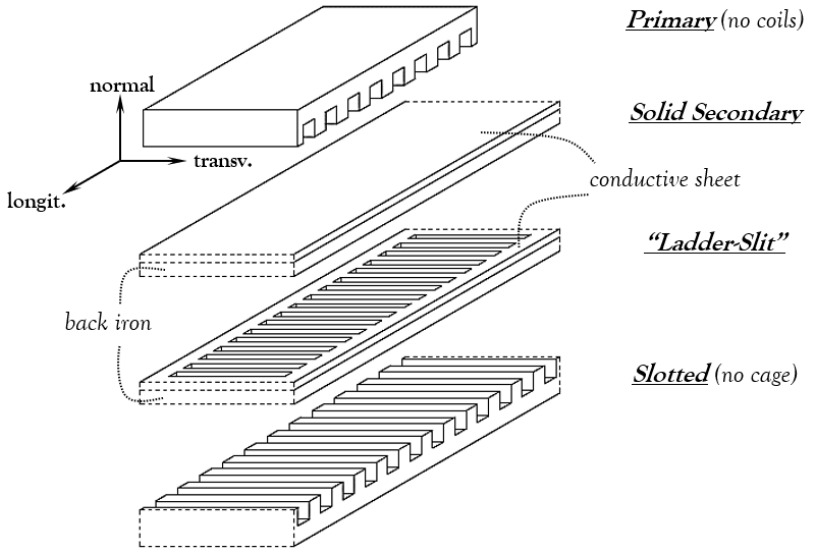
Figure 1. Difference between solid, ladder, and slotted